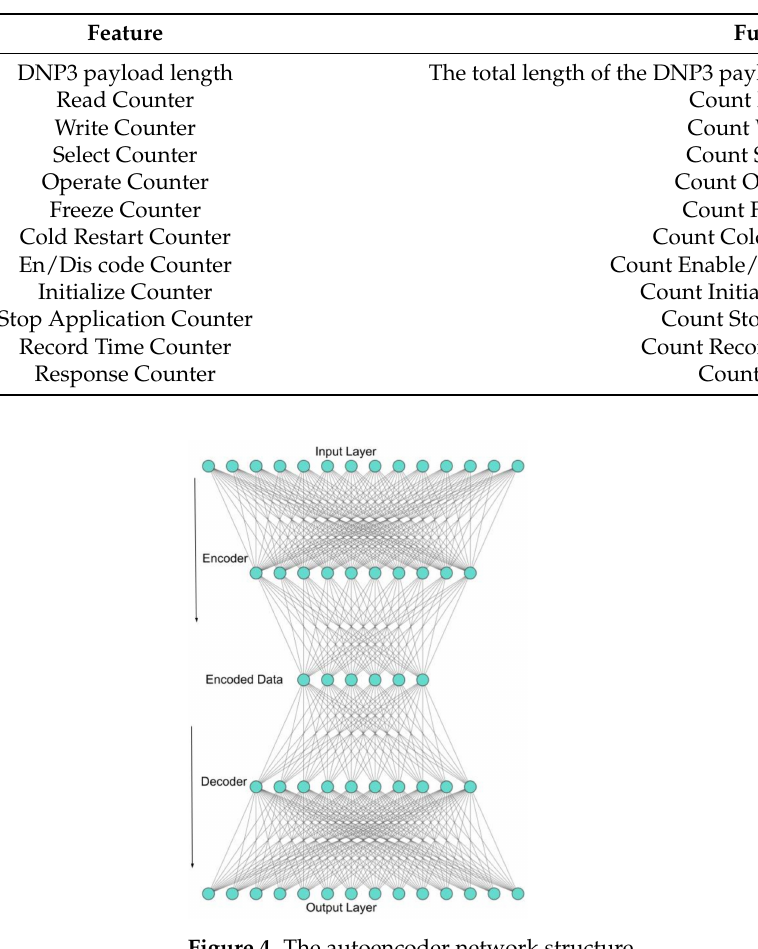
Figure 3. Two-level feature extraction. Table 3. List of DNP3 input features.